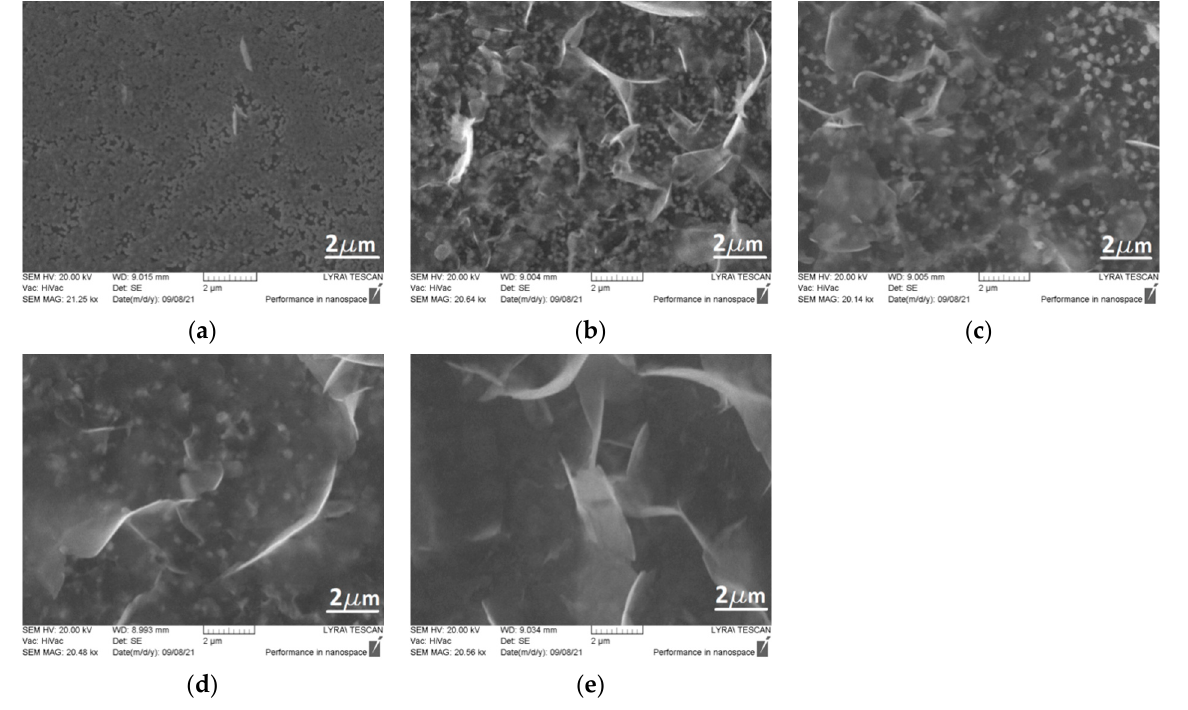
Figure 4. SEM images of ZnO layers, electrochemically deposited with different concentrations of